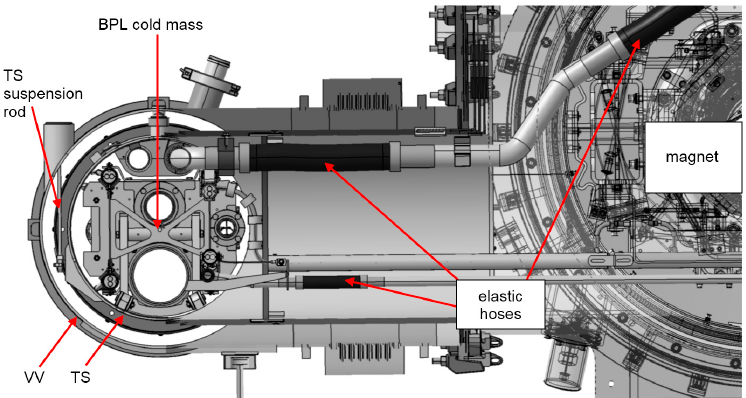
Figure 10. Connection of the BPL cold mass to the magnet in a lateral direction by elastic hoses on process pipes.